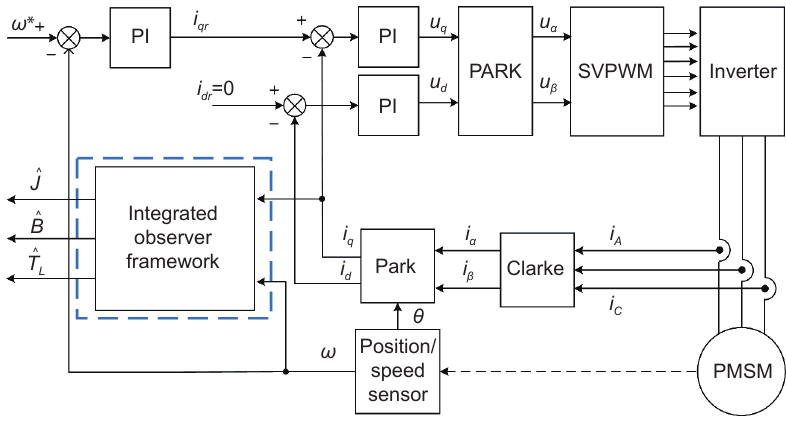
Fig. 1 Framework of mechanical parameter